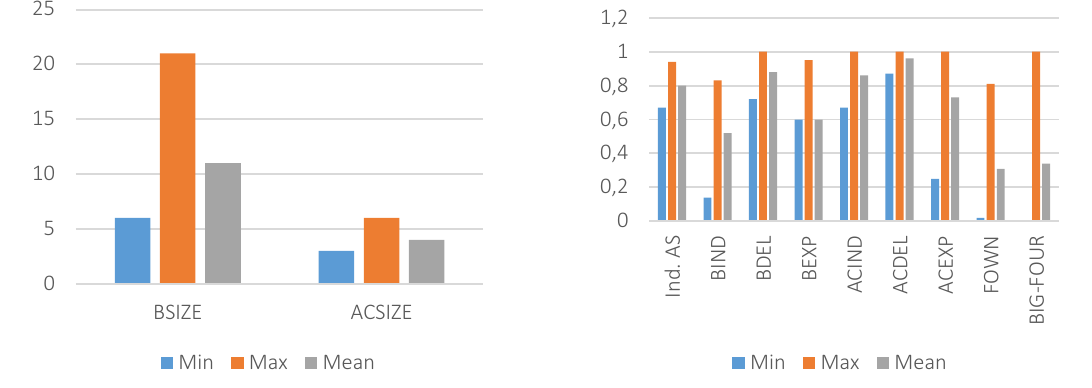
Figure 2. Descriptive statistics for CG